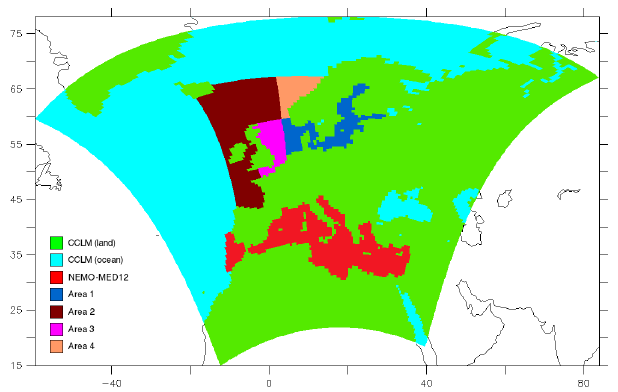
Figure 1. Map of coupled-system components. The horizontal domains of all components are bounded by the CCLM domain (CORDEX-EU), except MPI-ESM ( = ECHAM + MPI-OM), which is solved on the global domain. The CLM and VEG3D domains cover CCLM (land). TRIMNP, CICE and NEMO-NORDIC share area 1. Additionally, CICE covers area 4, NEMO-NORDIC area 3 and TRIMNP areas 2, 3 and